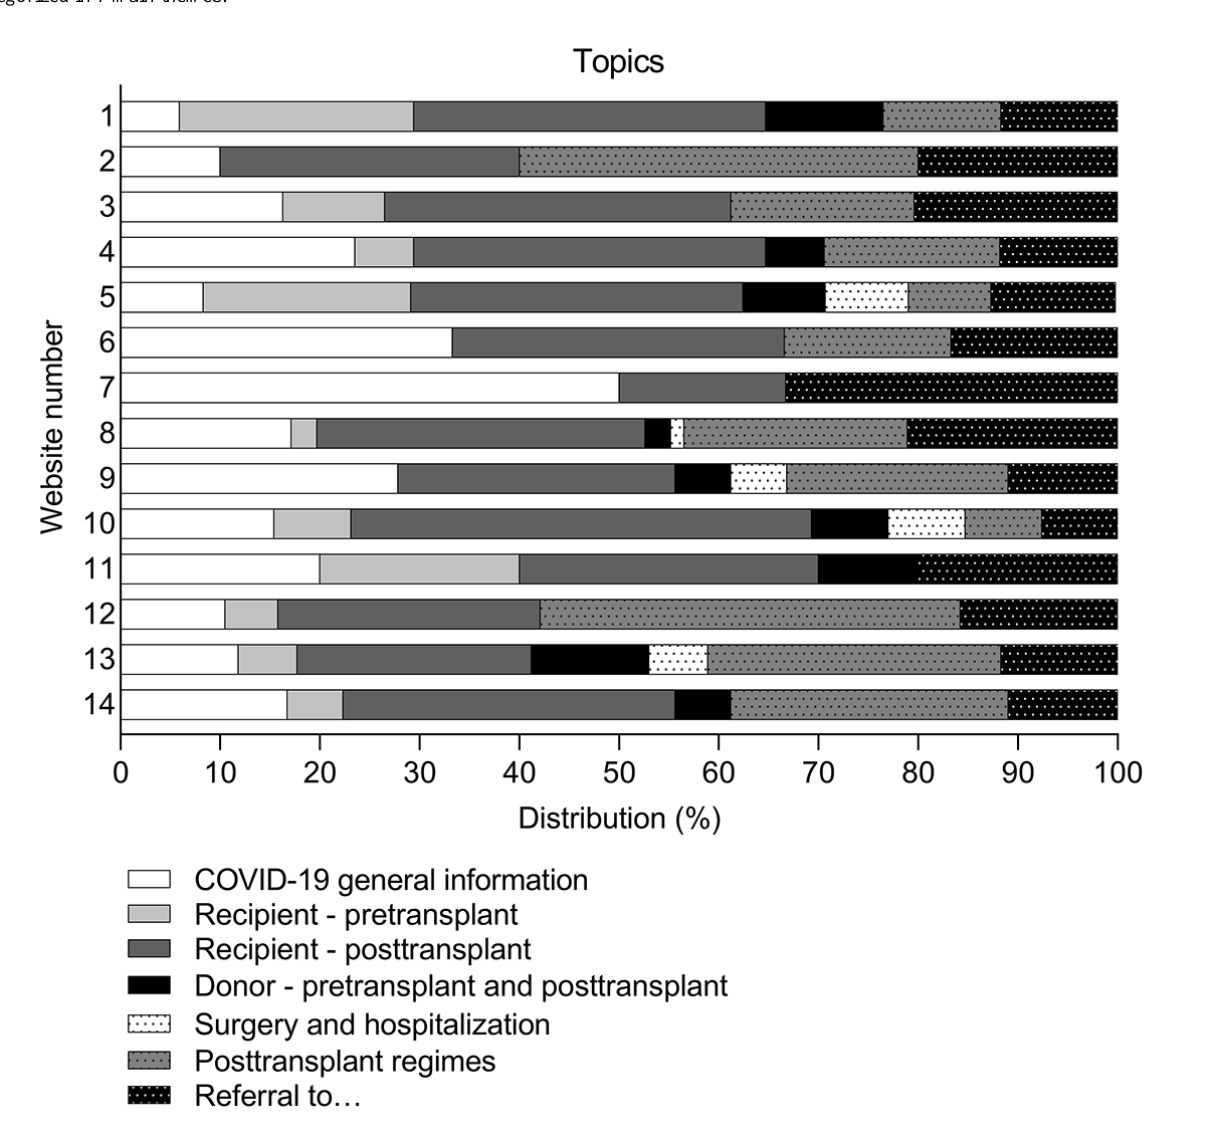
Figure 1. Distribution of different topics discussed on the included websites on COVID-19 for patients undergoing renal transplant and living donors, categorized in 7 main